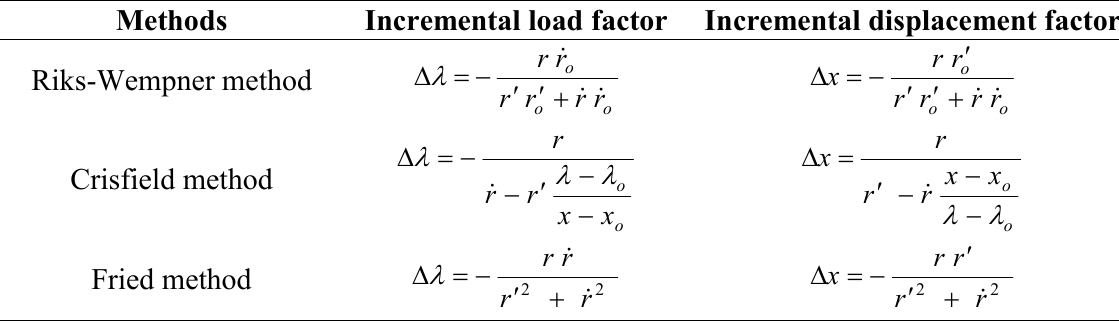
Table 1. Mathematical expressions for different arc-length